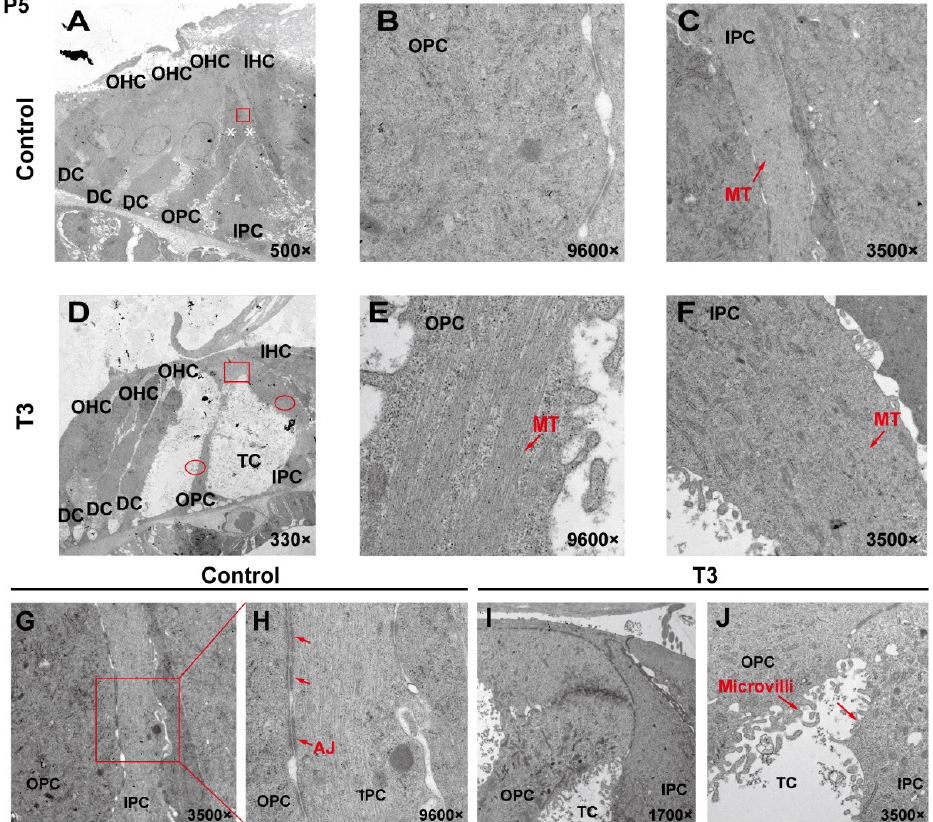
Figure 2. The ultrastructure of PCs changes significantly after T3 administration. ( A , D ) Transmission electron micrograph showing a closed TC from the P5 control group and an opened TC from the P5 T3 group (White asterisk indicate the location of PCs of ( B , C )). Plane ( B , C ) transmission electron micrograph showing OPCs and IPCs of control mice, and Plane ( E , F ) showing the OPCs and IPCs of T3-induced mice. Plane ( G , H ) the junction of OPCs and IPCs from control mice, and Plane ( I , J ), the junction of OPCs and IPCs from T3 ‐ induced mice. MT: microtubule; AJ: adherens junction.